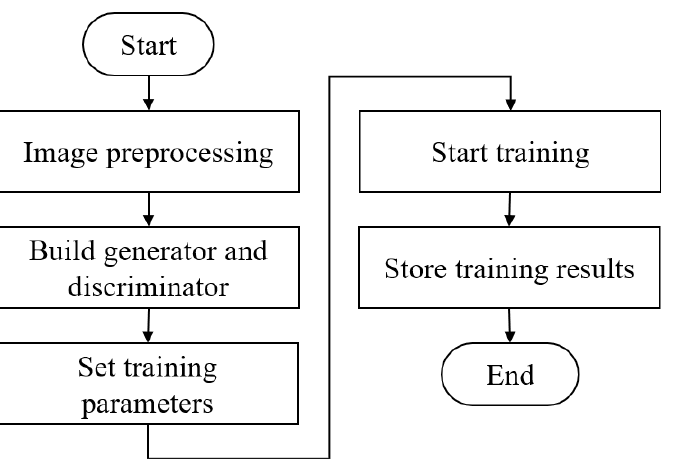
Figure 17. Flowchart showing the implementation of the proposed generative adversarial networks.